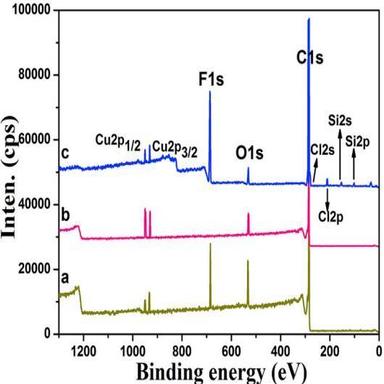
XPS of (a) Cu-PFBA, (b) Cu-SA and (c) Cu-TCPFOSi system.